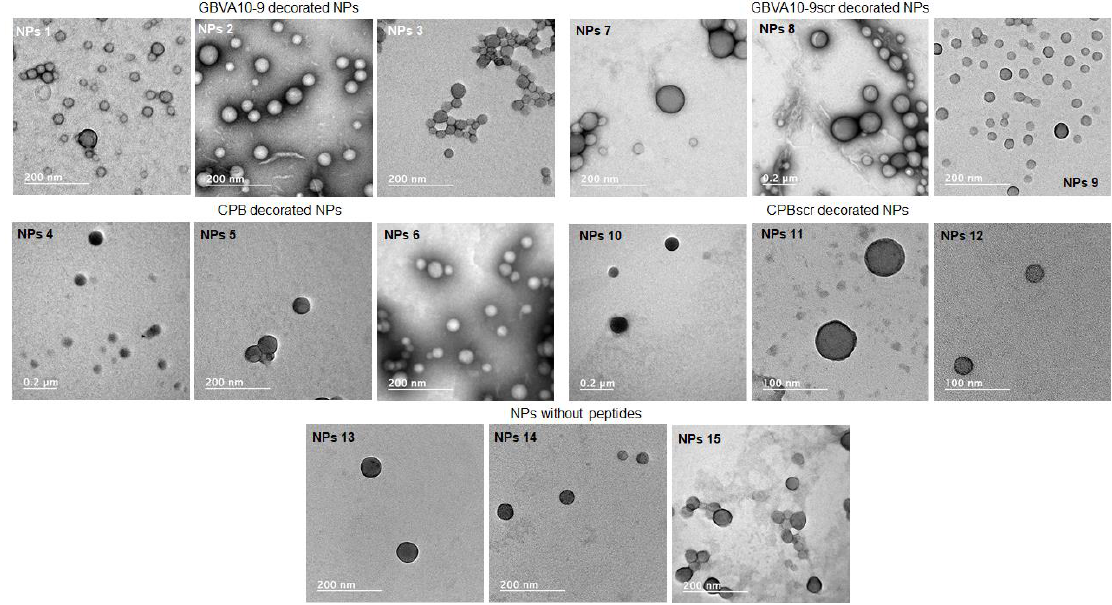
Figure 7. TEM images of peptide-decorated and native NPs.